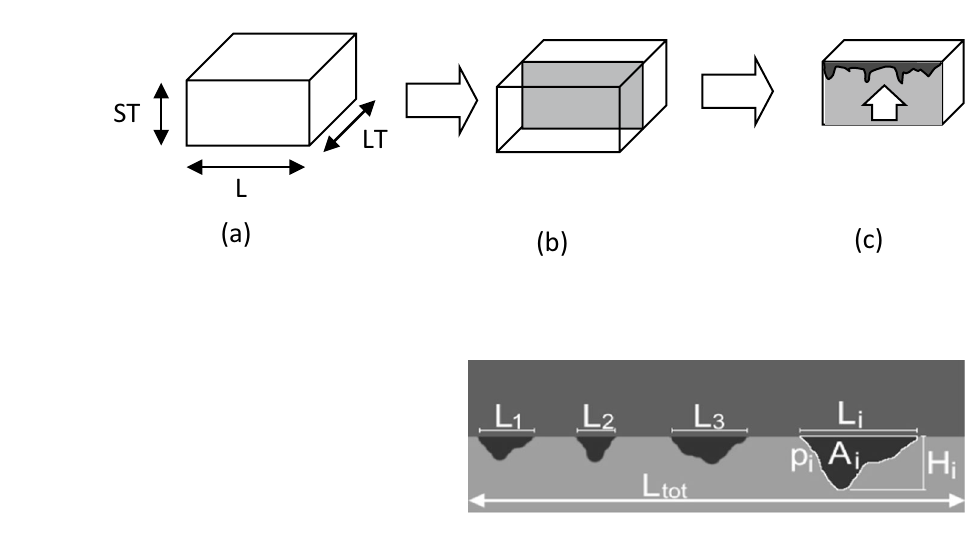
Fig. 4 Image analysis of a cor- rosion